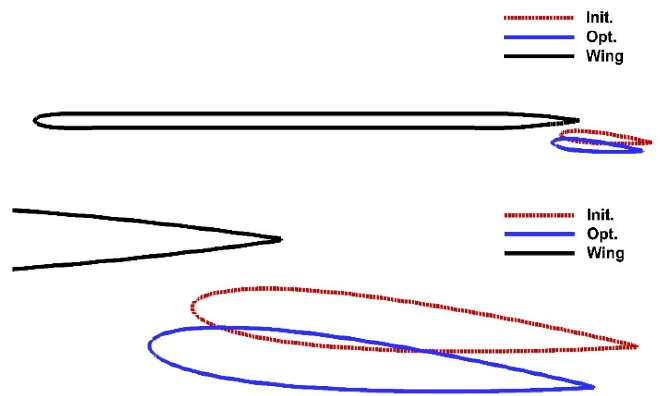
Figure 22. Comparison between initial shape and optimal shape.